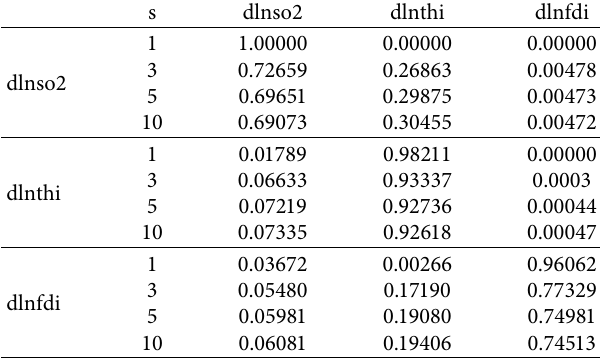
Table 6: The PVAR variance decomposition results of Model (2).